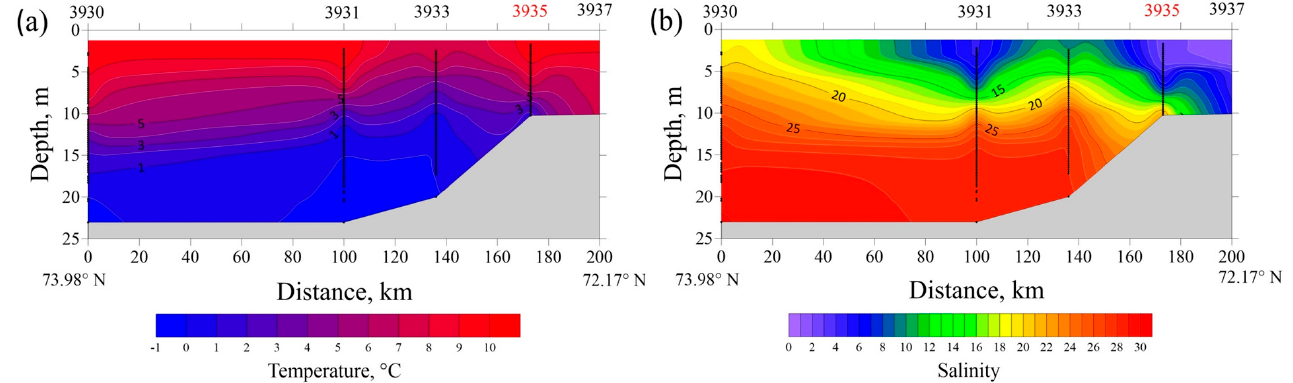
Figure 13. The vertical temperature ( a ) and salinity ( b ) structure along the transect in the Gulf of Ob (15–16 August, 2021). Water samples analyzed in this study were collected at station no. 3935 (indicated by red).